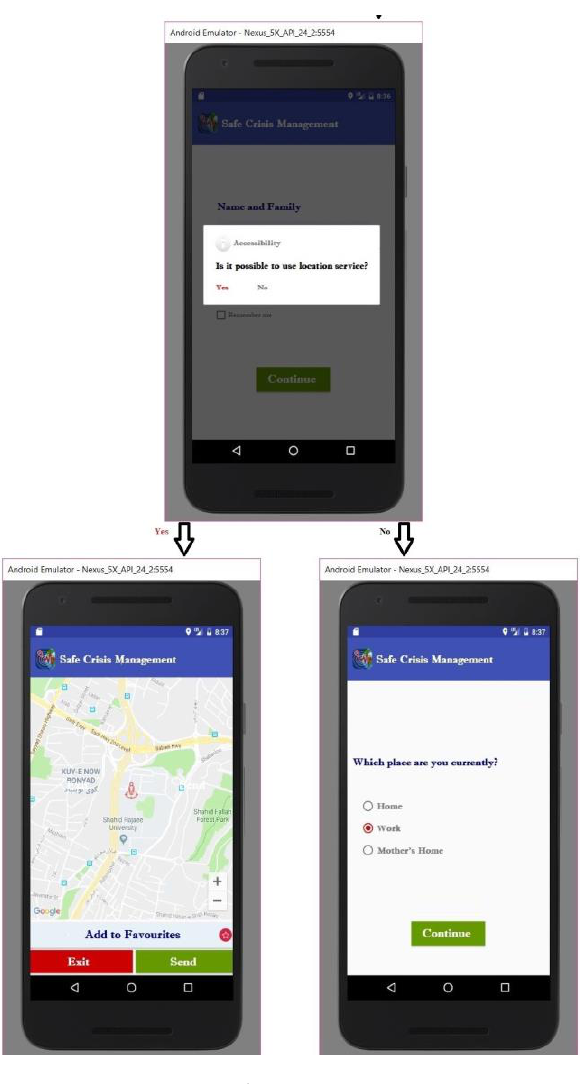
Figure 15. Location page (Using location service if possible or select saved location if not possible)